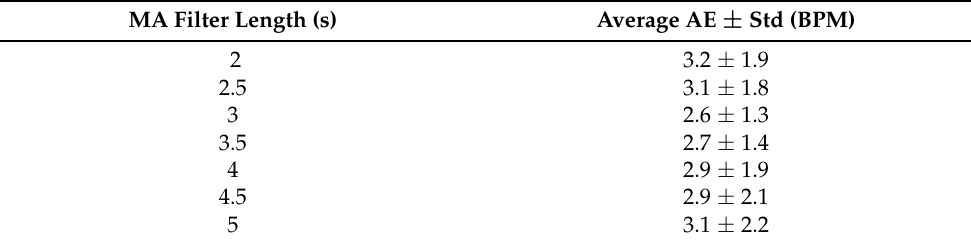
Table 1. The Influence of MA Filter’s Length on the RR estimation.